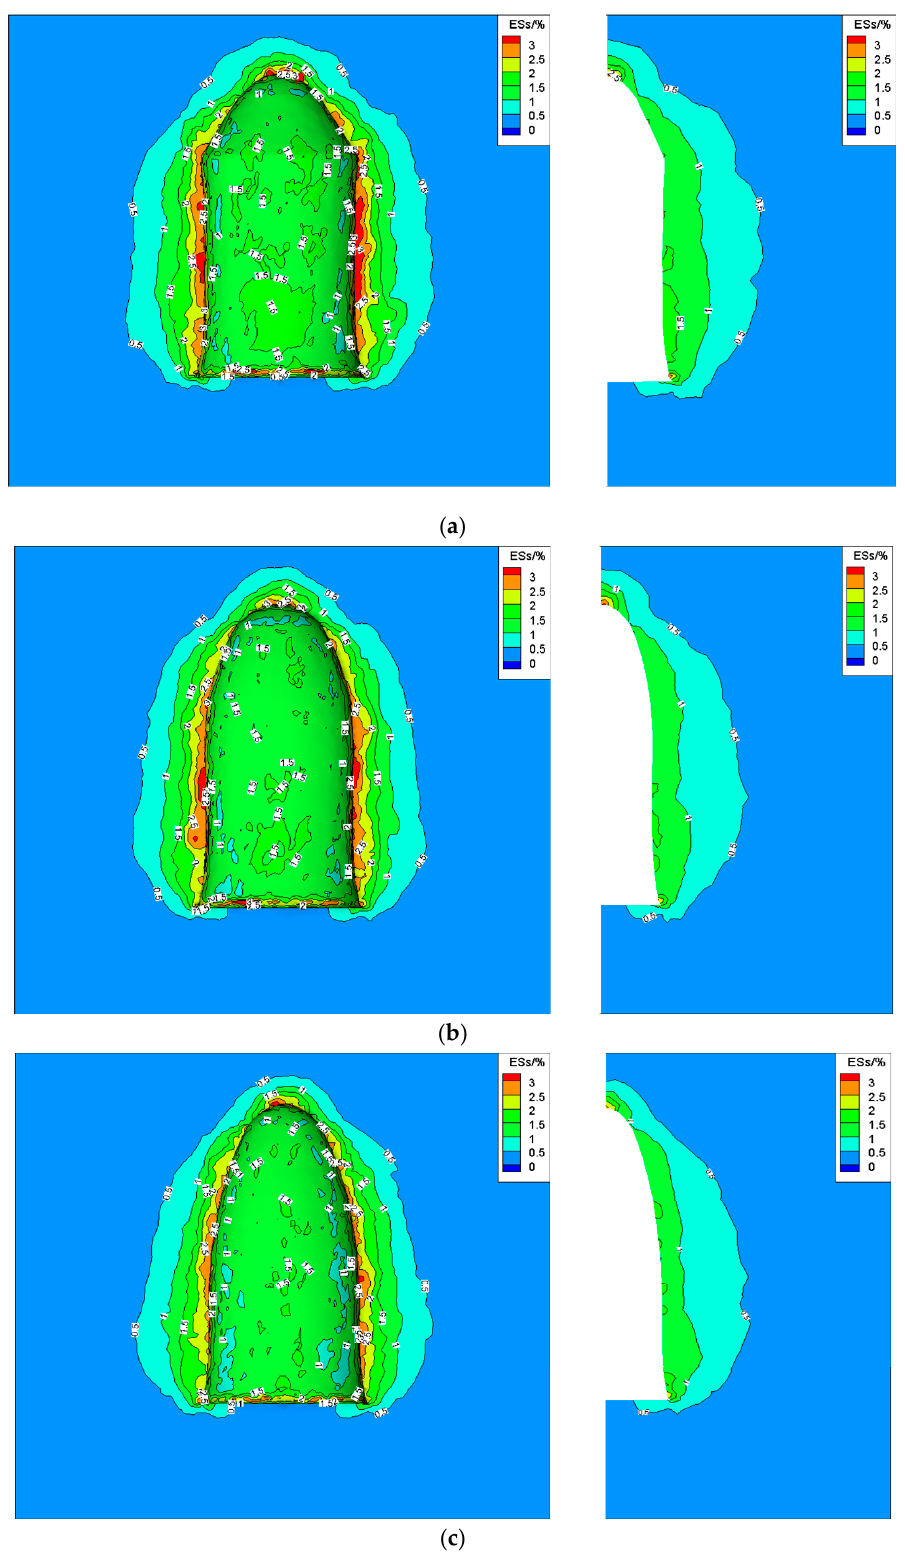
Figure 10. Equivalent strain contours of the cavern with different upper shapes after operating for 30 years under internal gas pressure of 14 MPa. ( a ) 40 m, ( b ) 70 m, ( c ) 100 m.